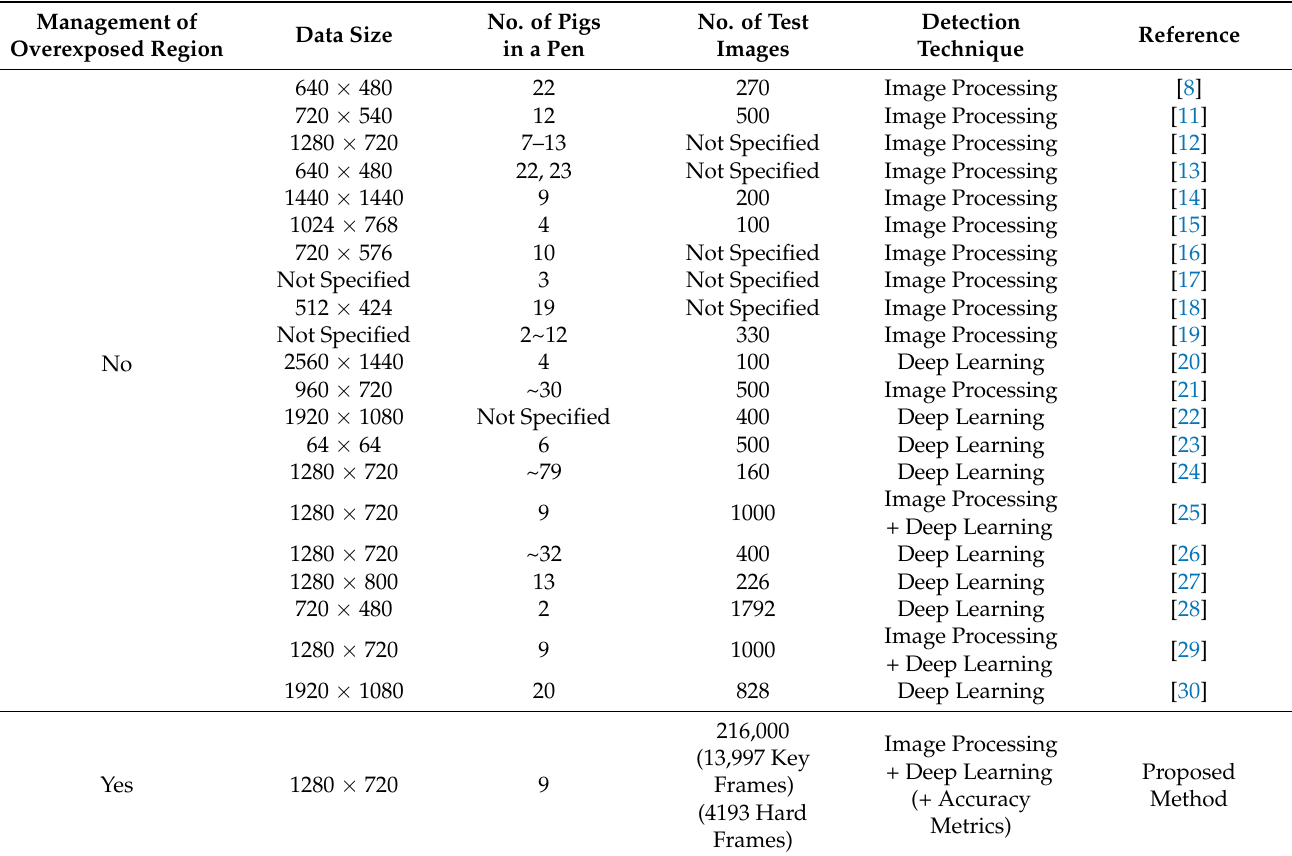
Figure 2. Individual pig detection results (infrared-based). ( a ) Daytime (12 p.m. and 3 p.m.); ( b ) nighttime (0 a.m. and 3 a.m.); ( c ) daytime with sunlight (9 a.m. and 10 a.m.). Missing (false negative) and false pigs (i.e., false positive) can be seen. Table 1. Some of the recent results for group-housed pig detection (published during